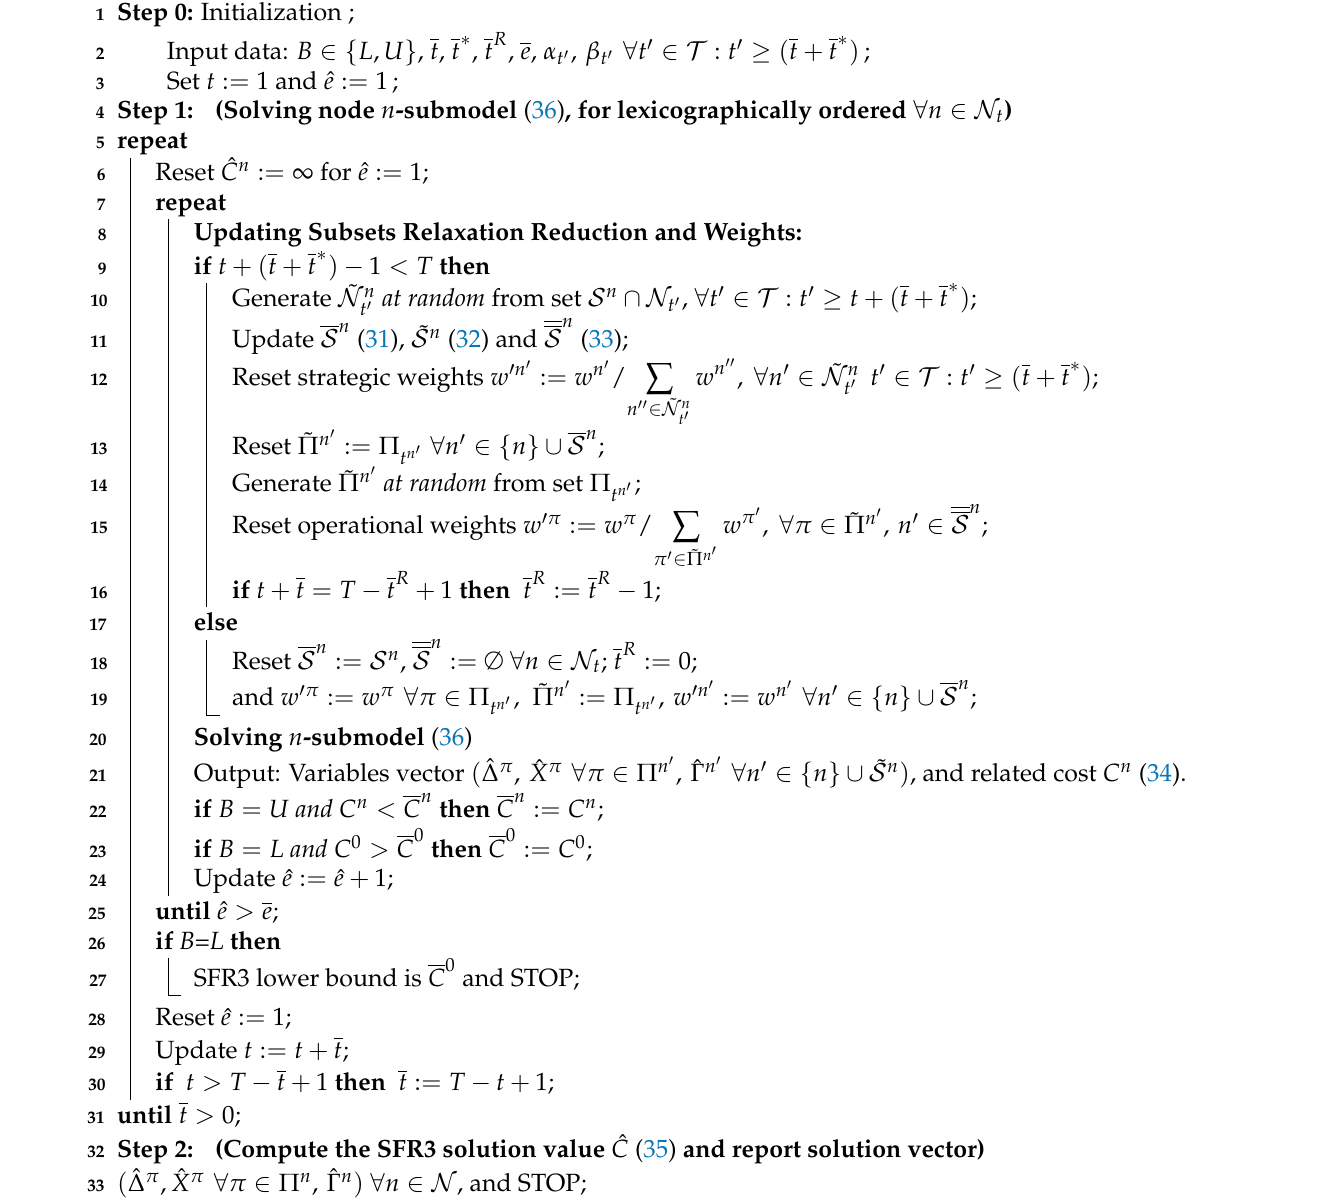
Algorithm 1: SFR3. On obtaining lower and upper bounds on MS-Hub-NEP model